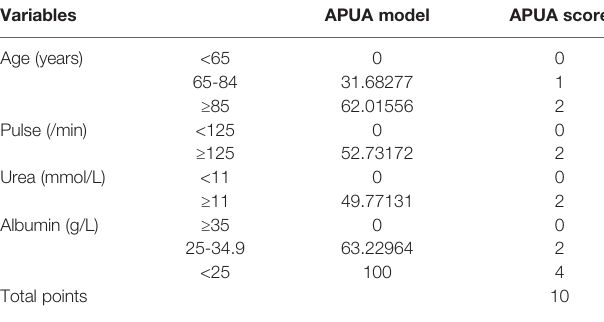
TABLE 1 | The simpli fi ed method of the APUA